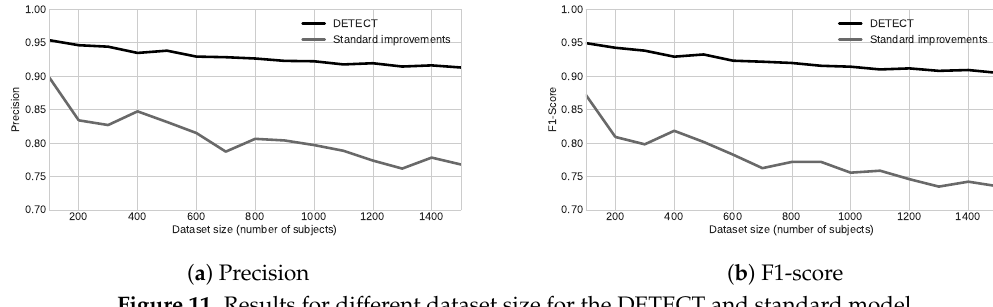
Figure 11. Results for different dataset size for the DETECT and standard